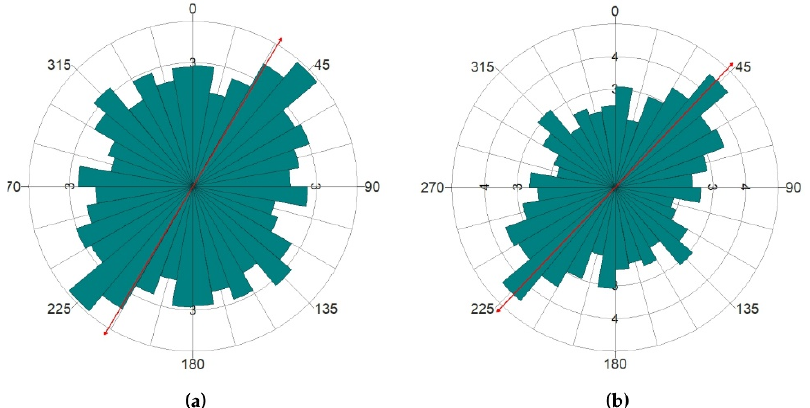
Figure 12 . ( a ) Rose diagram showing the main trends obtained for the total automatic extraction lineaments; ( b ) rose diagram of automatically extracted lineaments greater than